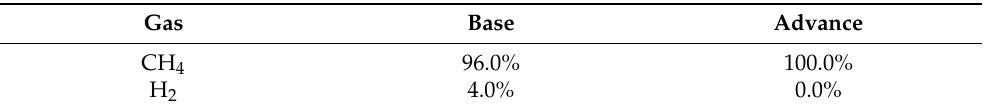
Figure 7. Gas composition (proportion of CH 4 , H 2 and CO 2 ) during injection and withdrawal. As the mass balance shows, a significant amount of gas is kept in the loop and injected again to the underground pore storage. The operating energy used for geo-methanation is solely made up by electricity for electrolysis, gas injection and gas withdrawal. For the scaling and the electricity consumption of the compressors, a calculation based on the real gas values of methane and hydrogen was performed [65,66]. The electricity demand for the advance case is estimated to be 728 MJ/h for electrolysis, 288 MJ/h for injection and ranges from 181 MJ/h for the advance case up to 233 MJ/h for the base case for gas withdrawal. Due to the obtained gas mixtures an allocation procedure for CH 4 and H 2 as energetically usable process outputs based on the lower heating value (LHV) was developed (see Table 3). Table 3. Energy allocation in scenarios based on LHV of H 2 (3.0 kWh/Nm 3 ) and CH 4 (9.9 kWh/Nm 3 ) and volumetric gas composition shown in Figure